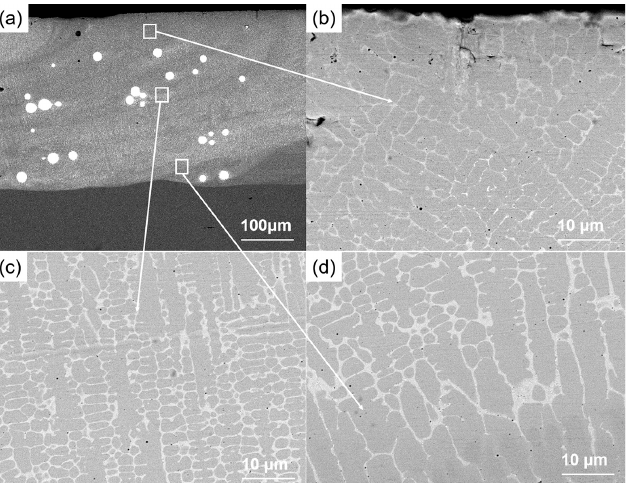
Figure 12. Back scattered electron images of longitudinal-section of FeCoCrNiWC coating deposited by the laser cladding: ( a ) microstructure of the coating; ( b ) magnification of the top region; ( c ) magnification of the middle region; ( d ) magnification of the bottom region. Reprinted with permission from Ref. [26]. Copyright 2019 Elsevier.